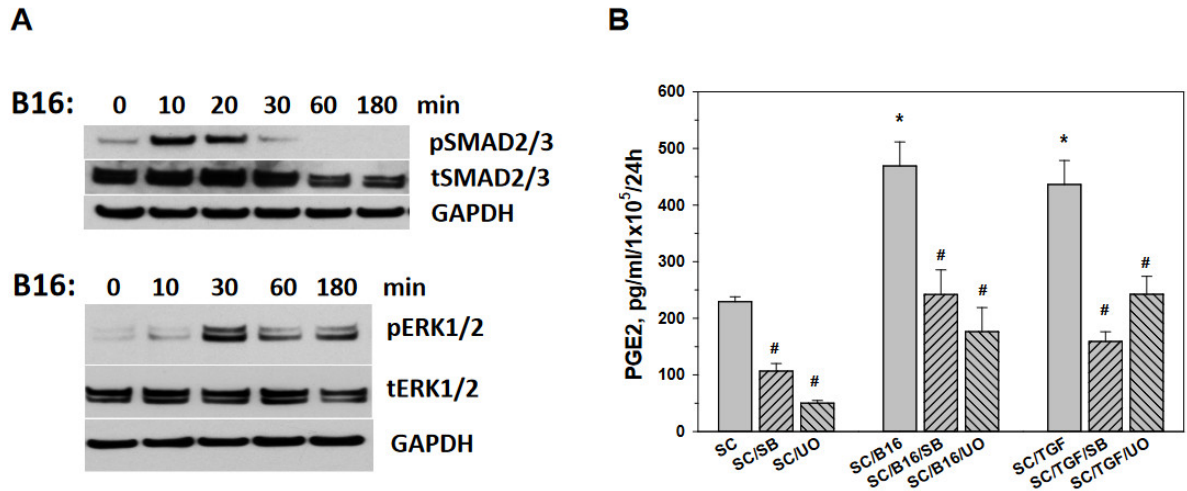
Figure 5. Tumor activated SC for PGE2 production via SMAD2/3 and ERK1/2 pathways. Adult SC were isolated from the sciatic nerve of C57BL/6 mice, cultured and purified as described in M&M. SC were then cultured with B16-conditioned medium (10% v / v ) for 0–180 min, harvested, washed in cold medium and used for cell lysate preparation for protein expression analyses. Expression of phosphorylated (p) and total (t) SMAD2/3 and ERK1/2 proteins in control and tumor-treated SC was determined by Western blot analysis after proteins were separated by SDS-PAGE electrophoresis and immunoblotted as described in M&M. Representative Western blot results are shown ( A ). SC were also co-cultured with medium (SC), B16-conditioned medium (10% v / v ) (SC/B16) and 10 ng/mL TGF- β 1 (SC/TGF) for 24 h after pre-treatment with either 10 µ M SB431542, a selective inhibitor of the TGF- β RI/ALK4/5/7 (SB) or 10 µ M UO126, a selective inhibitor of MAPK/ERK kinase (UO). Pre-treatment with medium served as a control. Cells were then washed and cultured for additional 24 h. PGE2 levels were then determined in cell-free supernatants by ELISA ( B ). Results are the mean ± SEM. *, p < 0.001 versus control SC group; #, p < 0.001 versus B16- and TGF- β -treated SC groups, respectively (n = 3, One-way ANOVA).